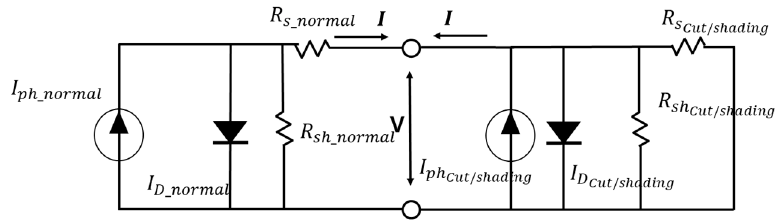
Figure 3. Equivalent circuit of a c-Si solar cell with cut or shading.